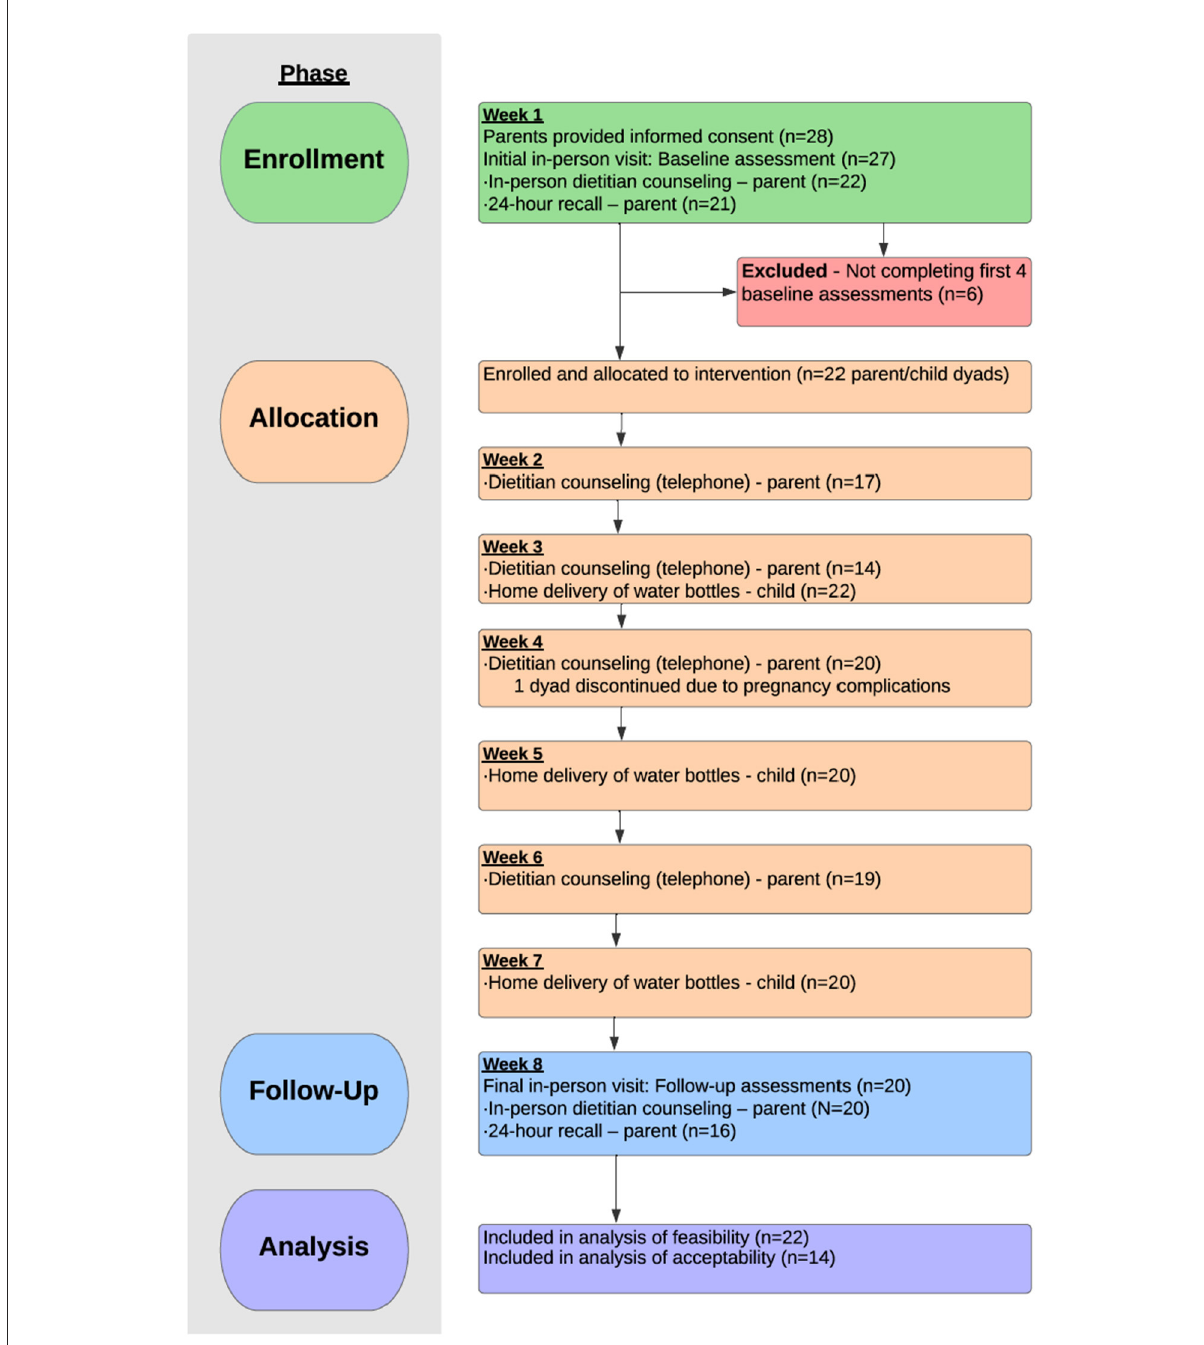
FIGURE1 Flow of participants through the stages of the Thirsty for a Smile study.